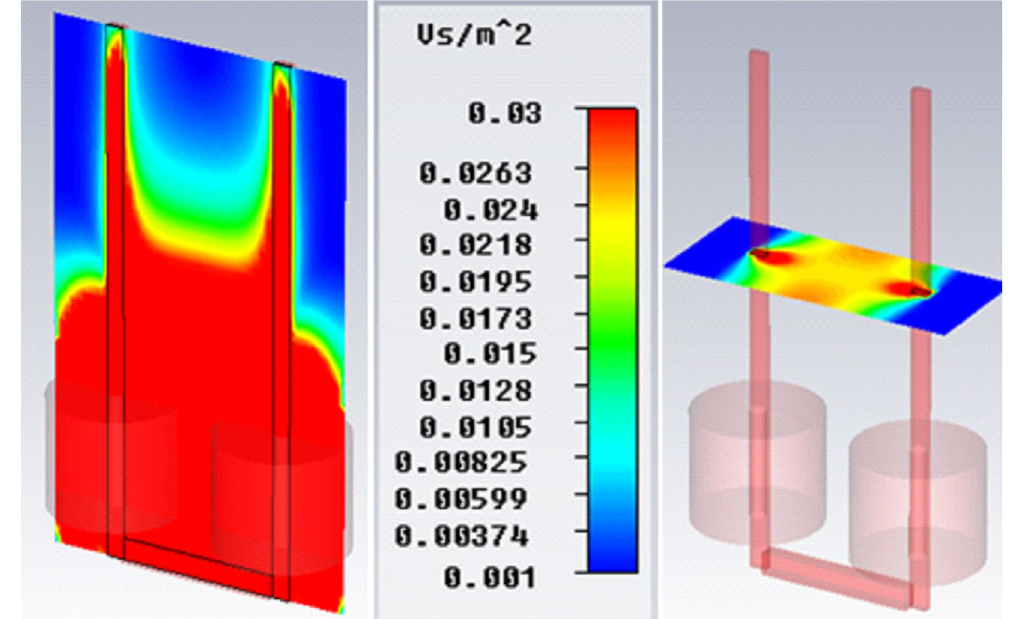
Figure 9. The distribution of magnetic field diagram in the iron blades and coils of exposure system. The place between two iron blades (pink axels), which is highlighted in yellow shows homogeneous magnetic field